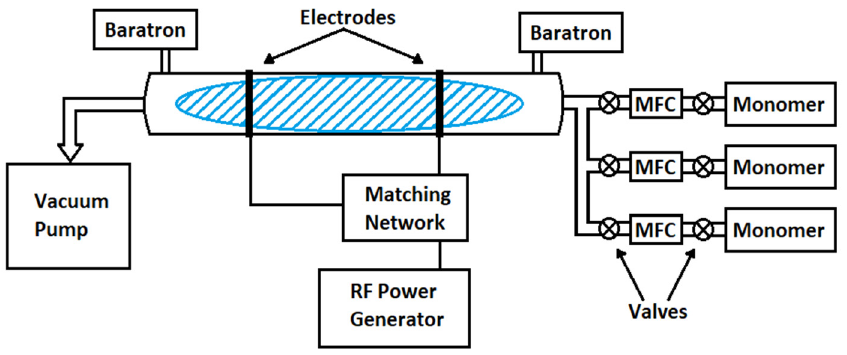
Figure 3. Schematic of Plasma Polymerization Figure 3. Schematics of Plasma Polymerization Reactor.